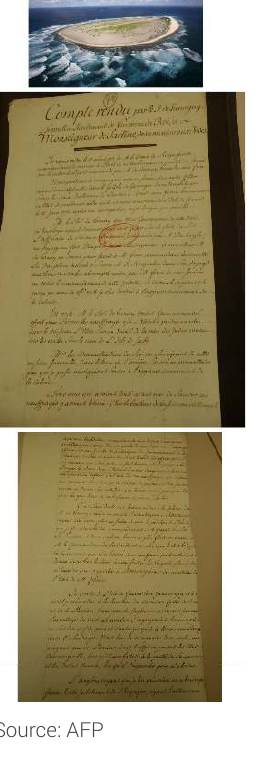
Figure 3. An aerial view of Tromelin